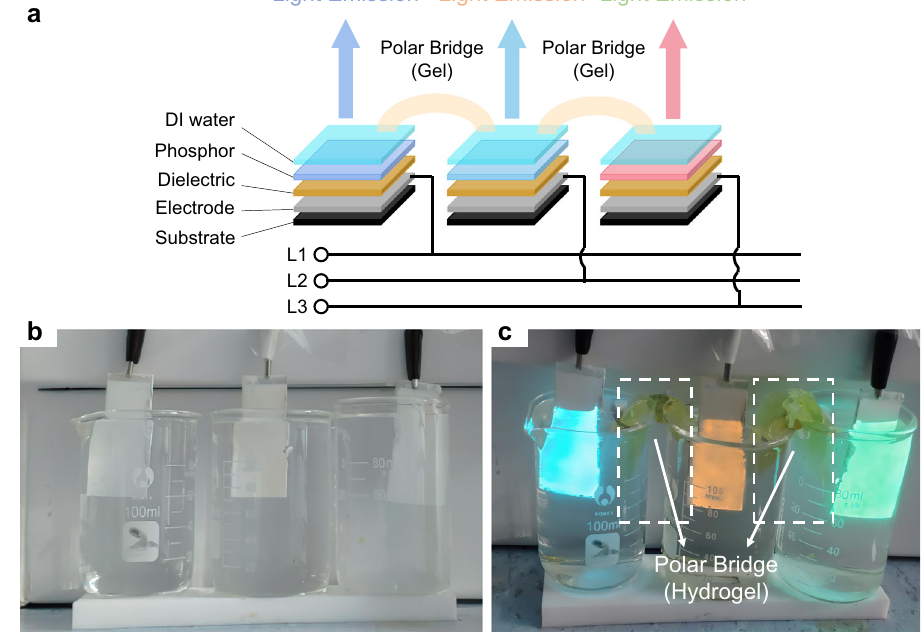
Fig. 4 Polar bridge experiments using separated TPEL units. a Schematic diagram of TPEL device separated into three parts, each driven by one single- phase AC supply of the three-phase electric power source, and connected together by a polar bridge. We used DI water as a polar bridge in each part, which are connected by hydrogel. b , c The photographs of three separate units, each connected to one single-phase AC supply of the three-phase electric power and placed into the beakers with DI water: b no bridges between the units (no light emission), c the units are connected by hydrogel bridges (each unit starts to emit the light from its phosphor layer). GG65, GG14, and GG45 were used as phosphors (from the left to the right) and glass-ITO was used as substrate/electrode.